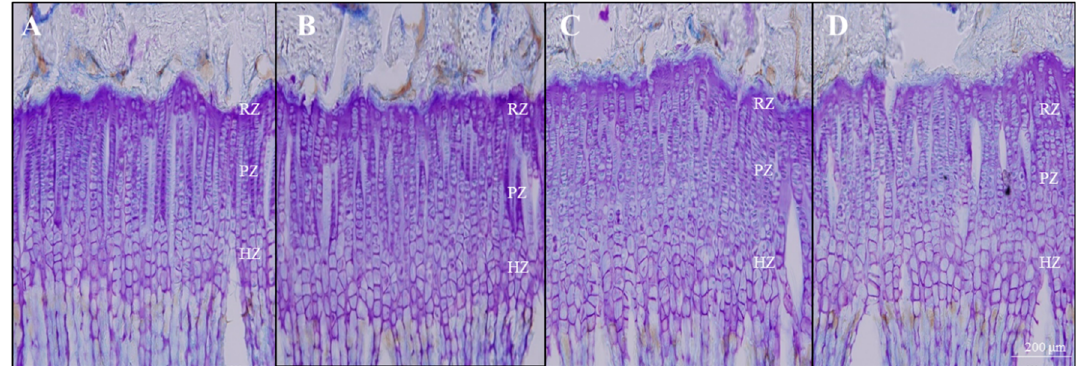
Figure 4. Representing microscopic pictures of Cresyl Violet stained chondrocytes of the proximal tibial GP in rats. ( A ) control group, ( B ) rhGH 200 μ g/kg group, ( C ) EEM 50 mg/kg group, and ( D ) EEM 200 mg/kg group. Scale bar is 200 μ m. Table 1. Zonal heights of each group in GP of proximal tibia in rats.